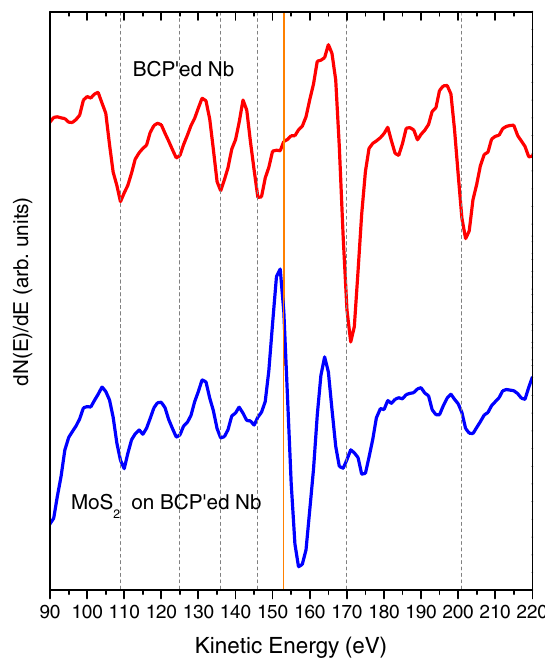
FIG. 3. AES spectrum (scaled) of a BCP niobium (red curve) and a MoS 2 -covered niobium surface (blue curve). The sulfur and niobium fingerprint peak positions are labeled by a solid orange line and gray dashed lines, respectively, for reading